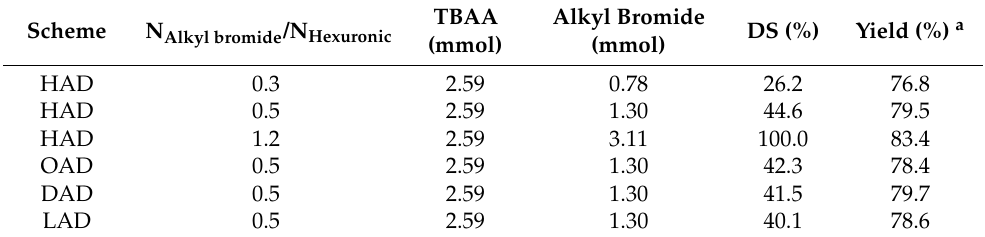
Table 1. Reaction parameters for the synthesis of AAD with different DS and yield.